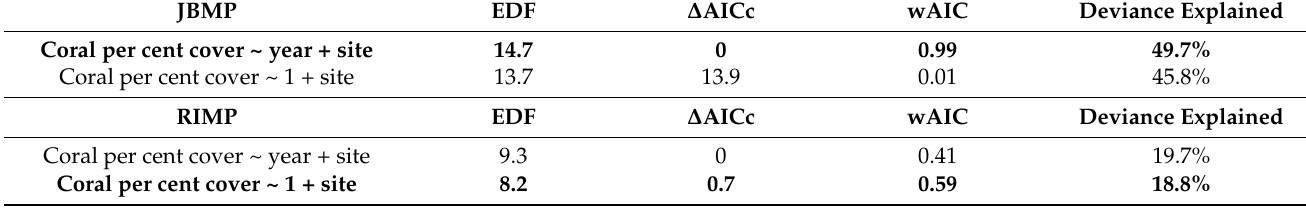
Table 2. Model selection table for generalized additive mixed effects models predicting coral occurrence and coral per cent cover year in Jurien Bay Marine Park (JBMP) and Rottnest Island Marine Reserve (RIMR). The difference between the lowest